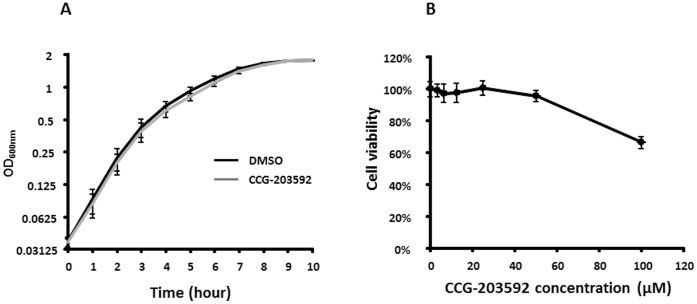
The effect of CCG-203592 on S. aureus and mammalian cell viability.A) Growth curves for RN6390 in the presence of CCG-203592 (50 µM) (grey curve) or DMSO alone (dark curve) as determined by OD600 nm. The data is presented as mean±standard error of means for a total of 9 samples (pooled from 3 independent experiments in triplicate). B) HeLa cell viability (as determined by mitochondrial reduction of MTT substrate) in the presence of CCG-203592 at different concentrations normalized to the value for DMSO treated samples which was defined as 100%. The data is presented as mean±standard error of means for a total of 12 samples (pooled from 3 independent experiments in quadruplicate).